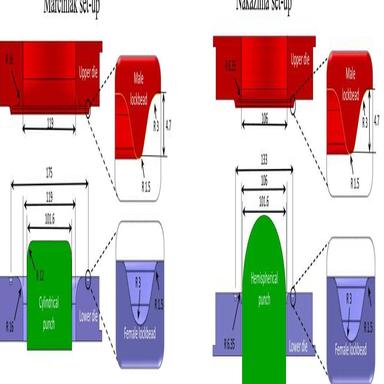
Tooling employed in the Nakazima and Marciniak formability tests. All dimensions are in millimeters.